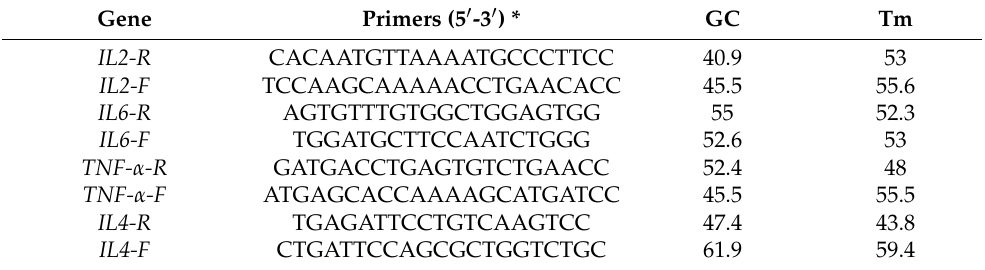
Table 2. Primer sequences designed to determine relative quantification of select cytokine